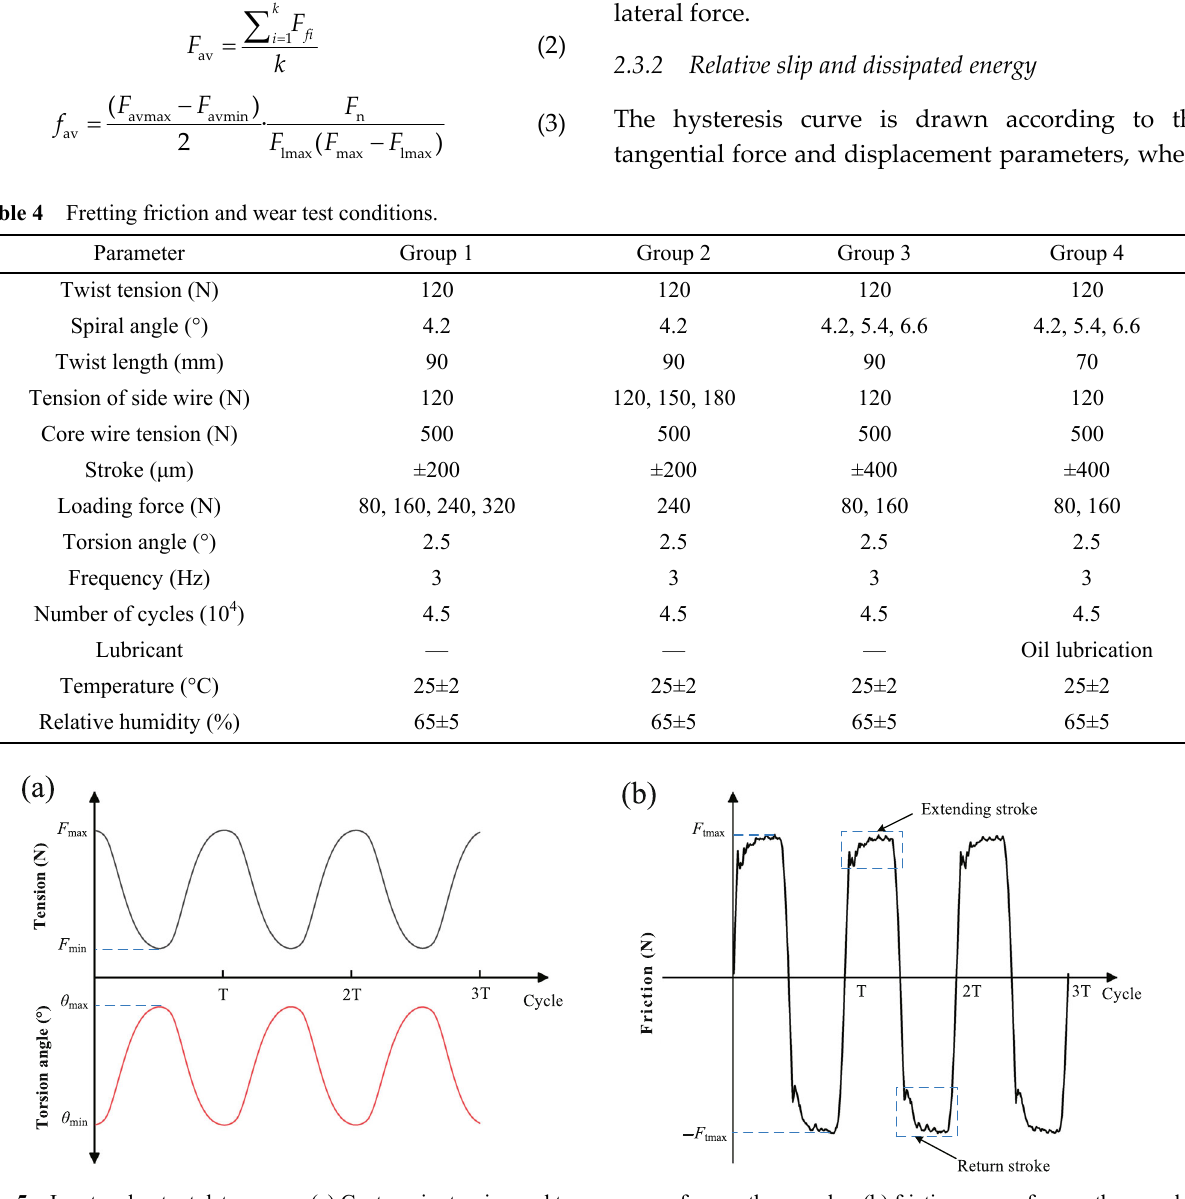
Fig. 5 Input and output data curves. (a) Center wire tension and torque curves for any three cycles, (b) friction curves for any three cycles. F max and F min are the maximum force and minimum force provided by the electric cylinder. θ max and θ min are the maximum and minimum torsion angles provided by the stepper motor, and they are in opposite directions. F tmax is the peak friction force of a single